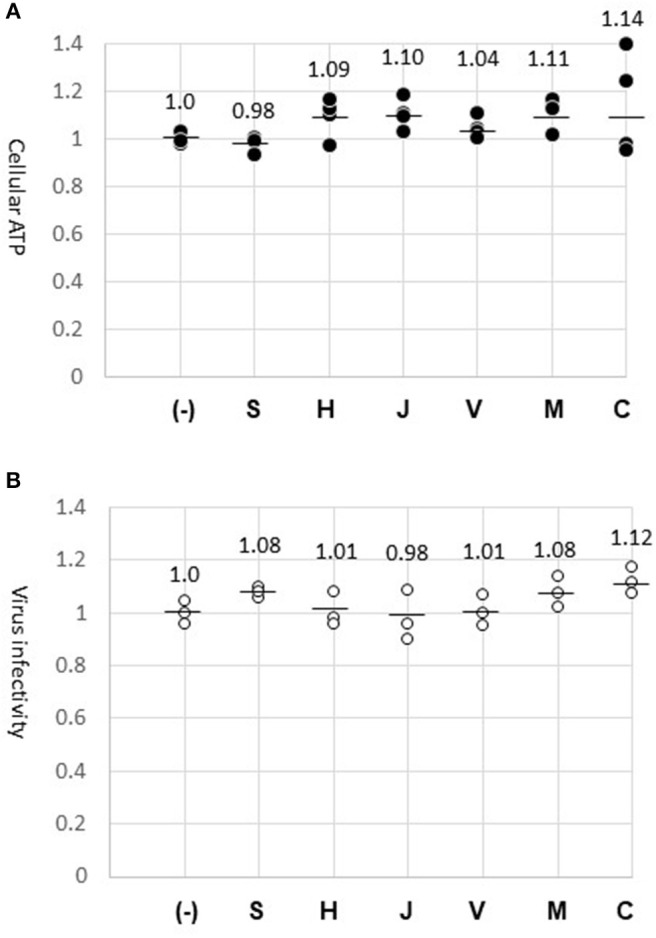
Absence of cytotoxic or anti-virus material on fabric surfaces. (A) Cellular ATP. Cells were incubated for 24 h with the media previously exposed to the surface of fabrics (S, H, J, V, M, and C) or the normal medium (–). ATP amount in the cell lysate was measured in four wells (dark dots) and indicated in relation to the control experiment (1.0). The mean of four measures is shown by a bar. (B) GFP-lentivirus stock was diluted 1:10 in the fabric-exposed medium for infecting HeLa cells. At 45 h, virus-infected cells were counted in three wells. The virus-infected cell numbers are indicated (circles) in relation to the control experiment (1.0).